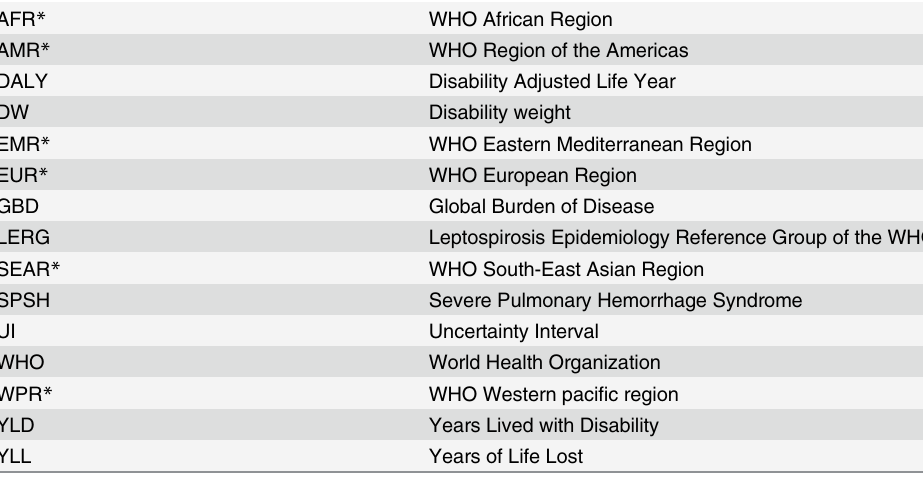
Table 1. List of abbreviations. AFR * WHO African Region AMR * WHO Region of the Americas DALY Disability Adjusted Life Year DW Disability weight EMR * WHO Eastern Mediterranean Region EUR * WHO European Region GBD Global Burden of Disease LERG Leptospirosis Epidemiology Reference Group of the WHO SEAR * WHO South-East Asian Region SPSH Severe Pulmonary Hemorrhage Syndrome UI Uncertainty Interval WHO WPR * YLD Years Lived with Disability YLL Years of Life Lost * WHO regions are further subdivided into subregions. A: very low child, very low adult mortality; B Low very high adult mortality. List of countries in each subregion is given in S1